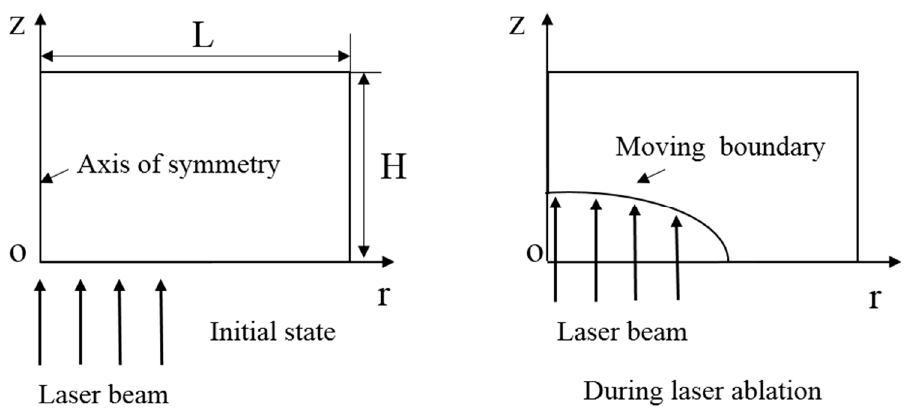
Figure 1. The model